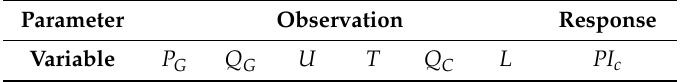
Table 3. Observations and responses of the Lasso